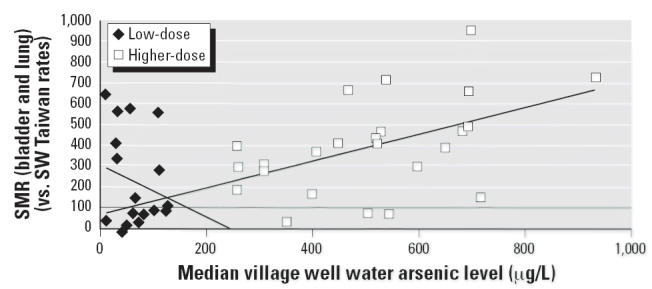
Bladder and lung cancer (combined) SMRs for low-dose villages and for higher-dose
villages by median village well water arsenic level (μg/L). Low-dose
villages (n = 18): y = 1.275x + 312; R2 = 0.04; p = 0.42. Higher-dose villages (n = 24): y = 0.639x + 71.2; R2 = 0.24; p = 0.02.